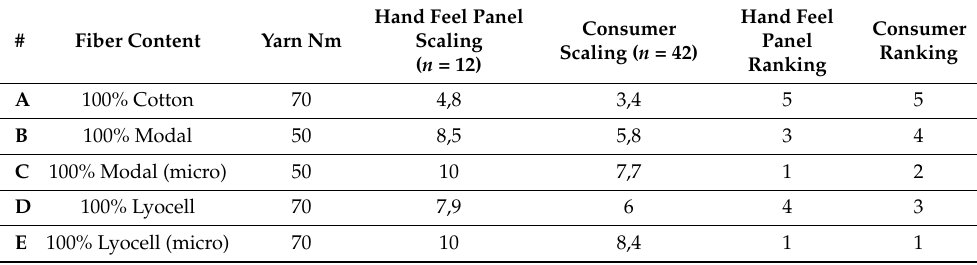
Table 5. Fabric description and evaluation